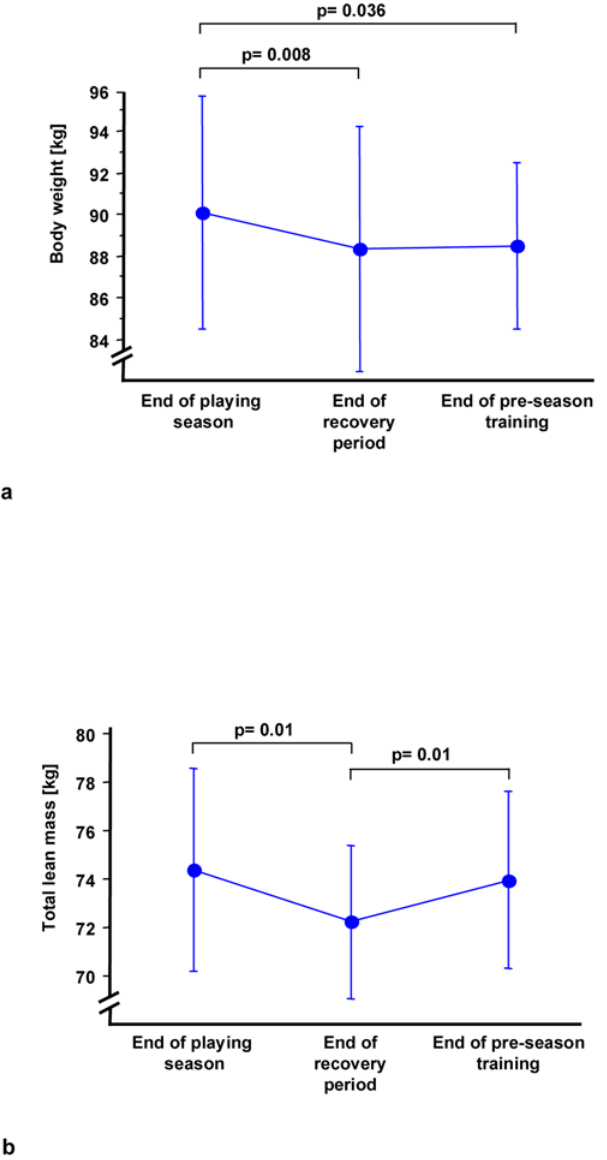
Figure 1. Changes in body weight (a) and lean mass (b) during different phases of physical